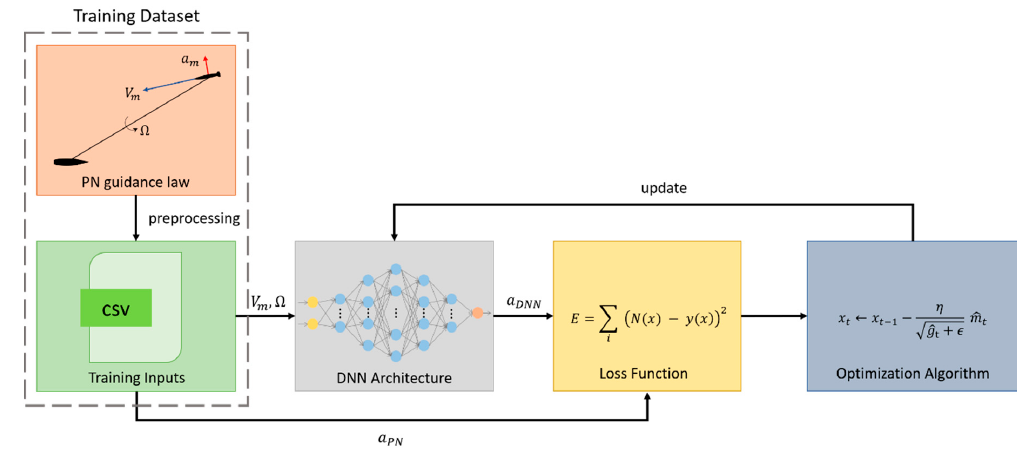
Figure 5. Learning process of supervised learning.